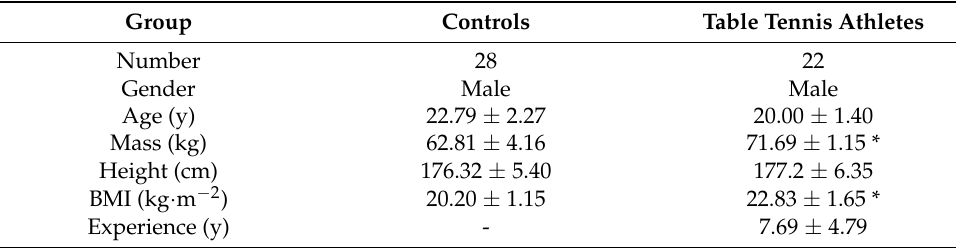
Table 1. Demographic information of each group (mean ± standard deviation).